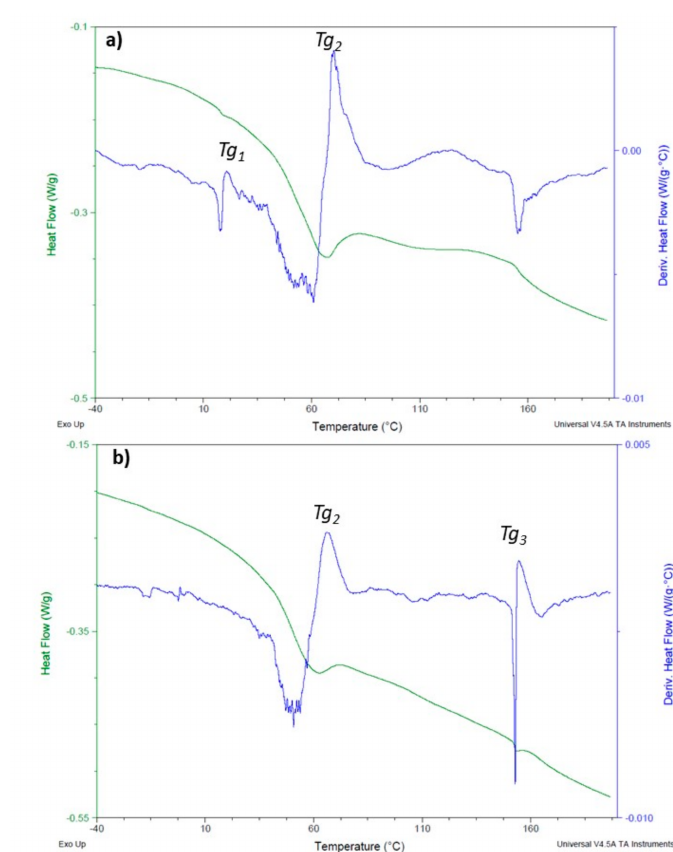
Figure5. DSCheatflowsandderivativesofspecimens1( a )and11( b ),showingtheT g valuesdetermination.